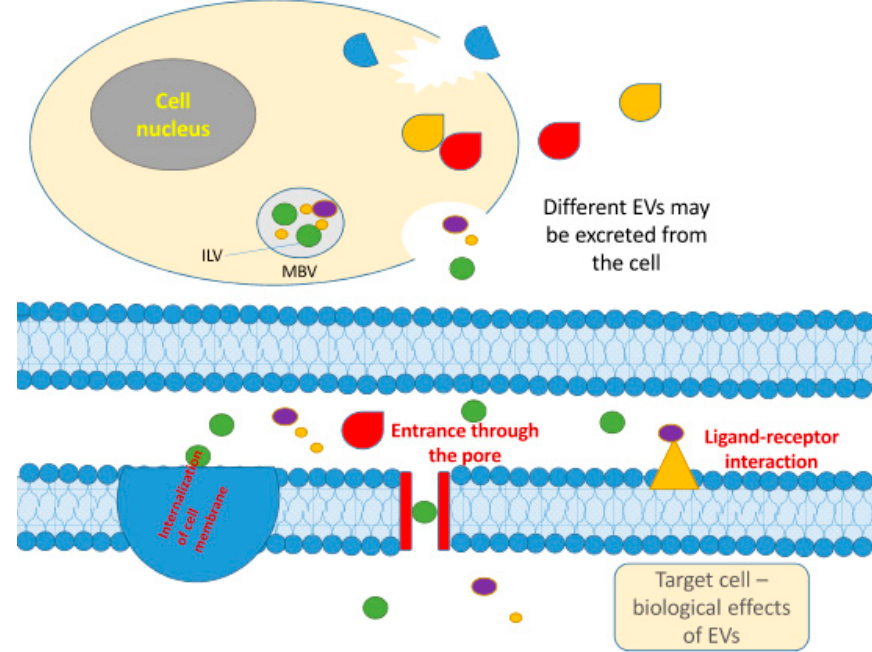
Figure 2. The generation for EVs within the cell and their role in cell-to-cell communication. Released EVs are heterogeneous and have different sizes. Among them, exosomes (up to 200 nm) are formed in the endolysosomal pathway as intraluminal vesicles (ILVs) within multivesicular bodies (MVBs). Different EVs may be formed and released from the cell. EVs affect the target cells through the delivery of their content into the target cell through internalization, ligand-receptor interaction or pore entrance.